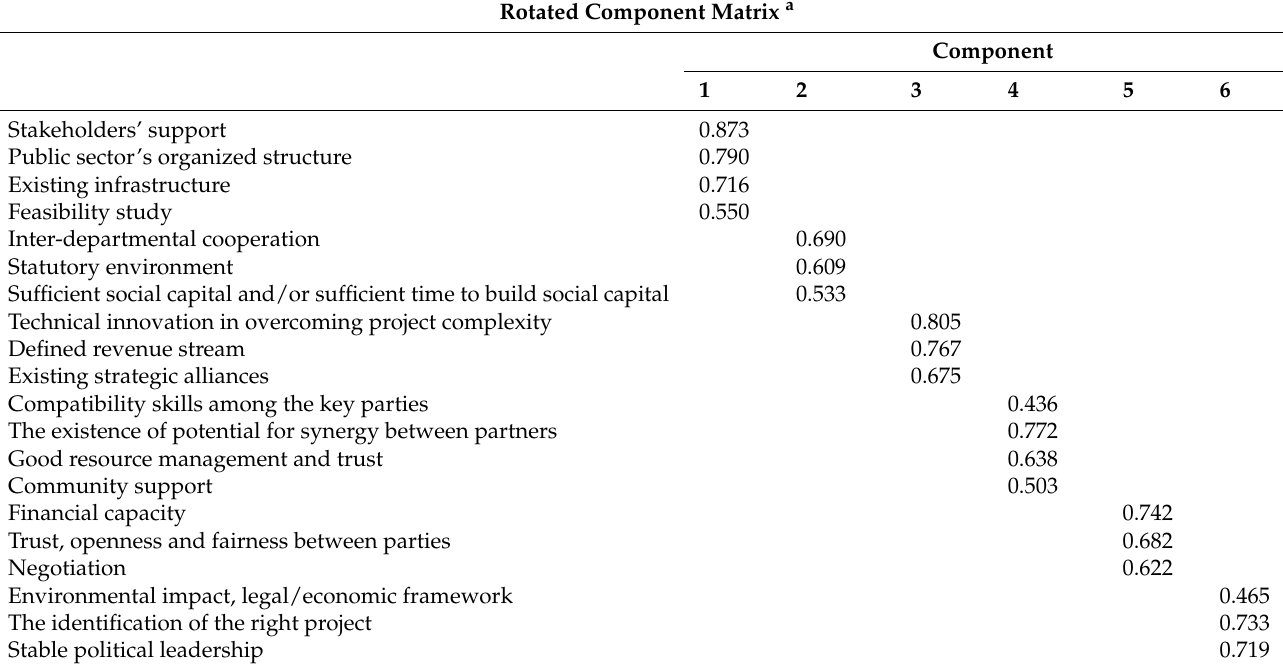
Table 3. Exploratory factor analysis